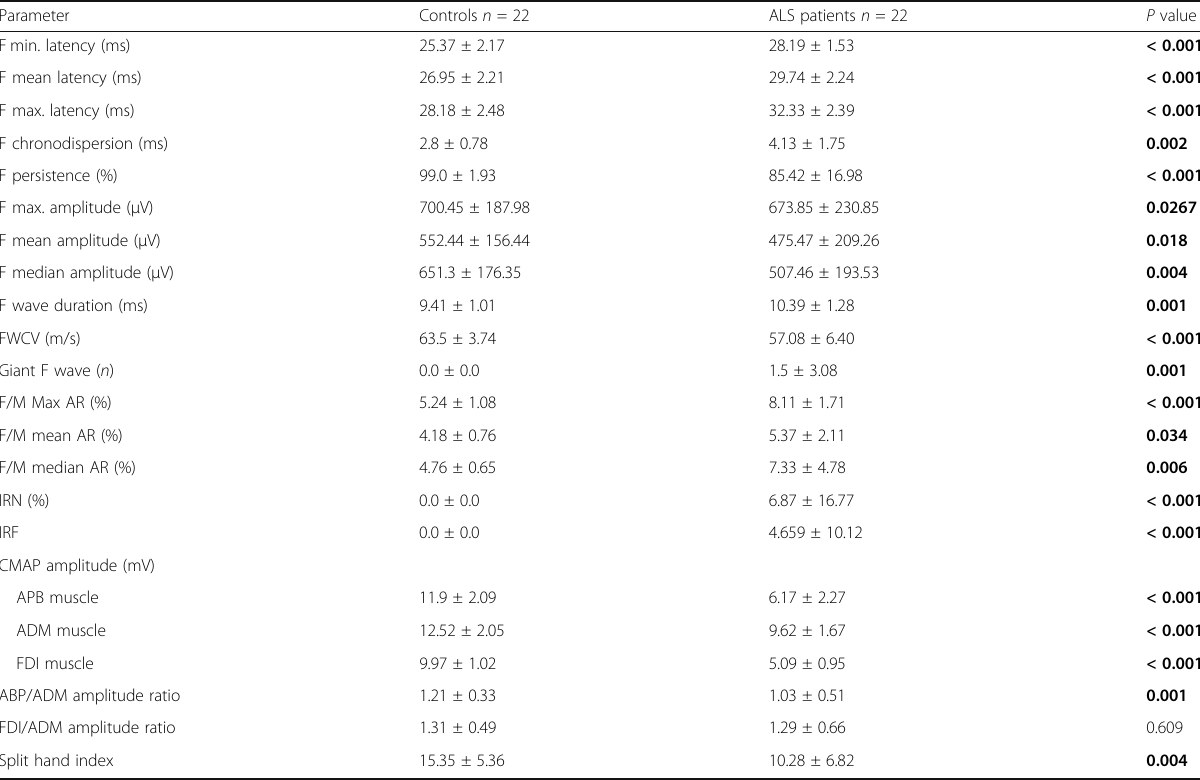
Table 2 F wave parameters and split hand index in patients with ALS and controls Parameter